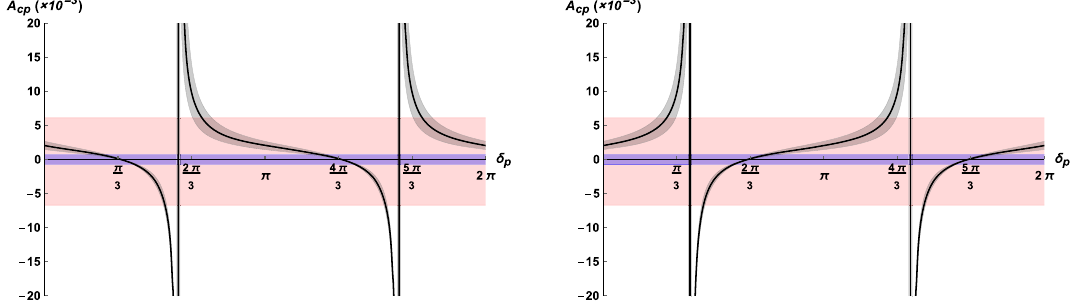
Fig. 2 CP asymmetry in the D 0 → π 0 π 0 decay dependent on δ p in the cases of negative (left) and positive (right) δ I . The horizontal pink shadow is 1 σ experimental limitation to date [40,42]. The blue shadow is the expected statistical uncertainties on Belle II at 50ab − 1 data set [43] In Eqs. (19) and (20), the first term in numerator is the C P between A 1 / 2 and A 3 / 2